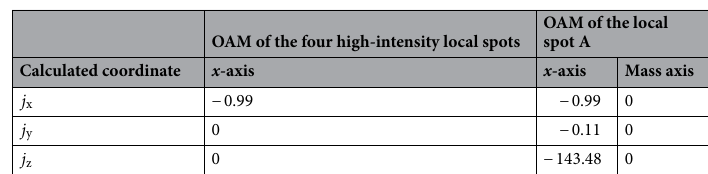
Table 2. OAM calculation of different regions. ℏ is regarded as 1 in this study.